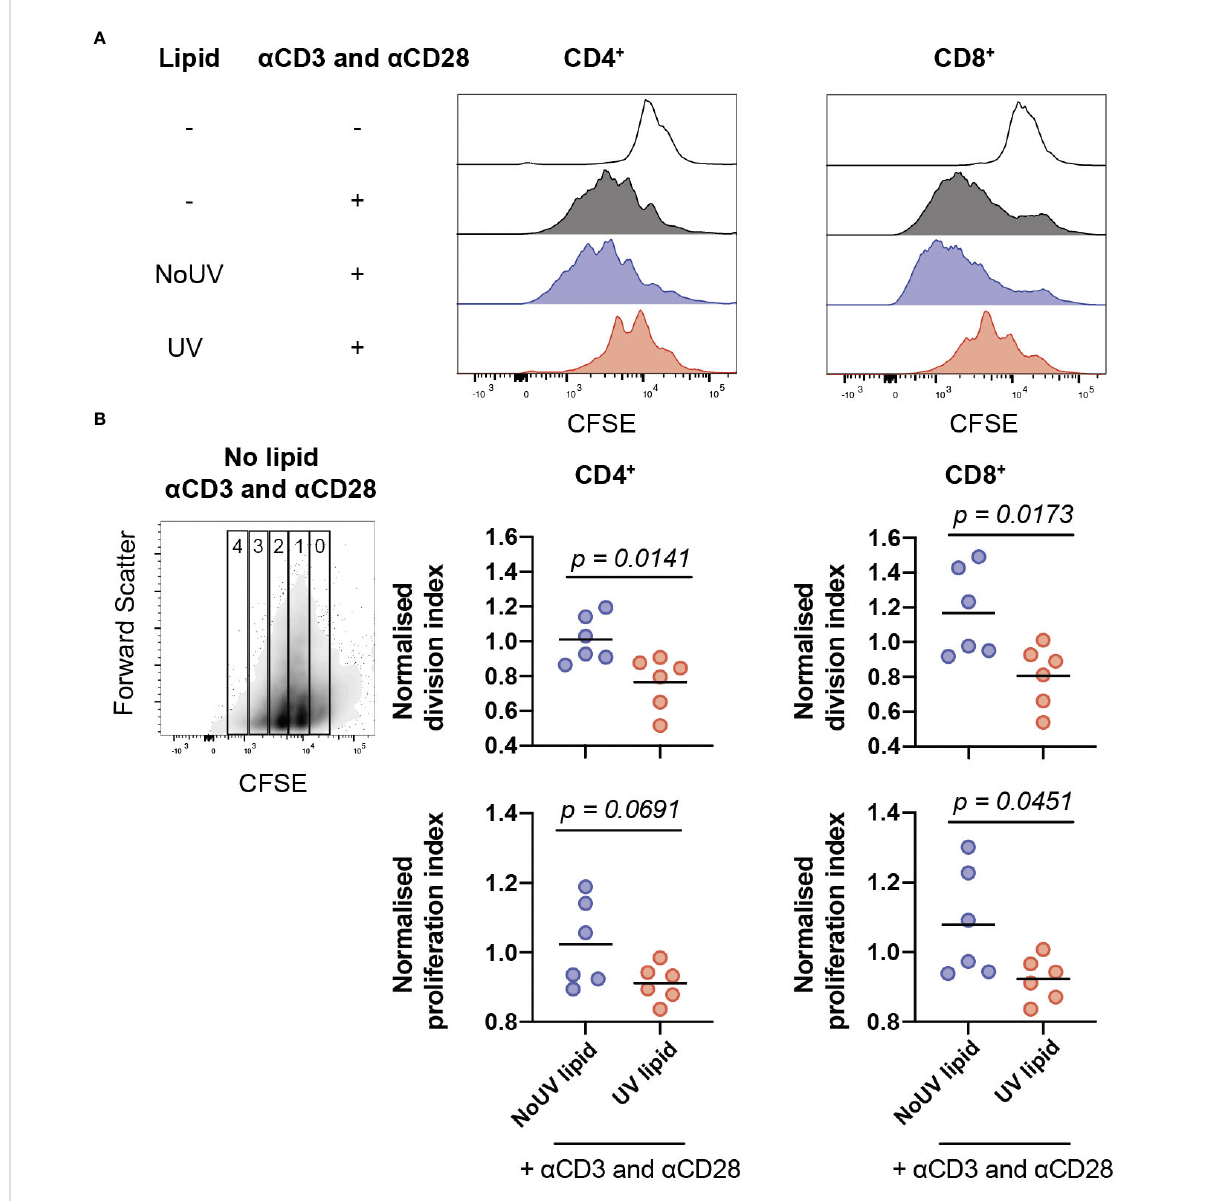
FIGURE 4 Lipids from UV-irradiated skin-draining lymph nodes suppress T cell proliferation. Skin-draining lymph nodes were collected and lipids extracted. Lipids were then added to CFSE-stained untreated skin-draining lymph node cells with or without anti-CD3 and anti-CD28. Cells were cultured for 72 h and assessed for CFSE expression by fl ow cytometry. (A) Representative histograms of CFSE expression in CD4 + and CD8 + T cells with and without lipids and/or stimulation. (B) Normalized division and proliferation index of CD4 + and CD8 + T cells with stimulation and either lipids from NoUV or UV mice. Division and proliferation indexes were normalized to the stimulated no lipid control of each independent experiment. Median and individual mice (lipid donors, n = 6) from 2 independent UV irradiation experiments are shown. Statistical analysis was by a two-tailed unpaired Student ’ s t